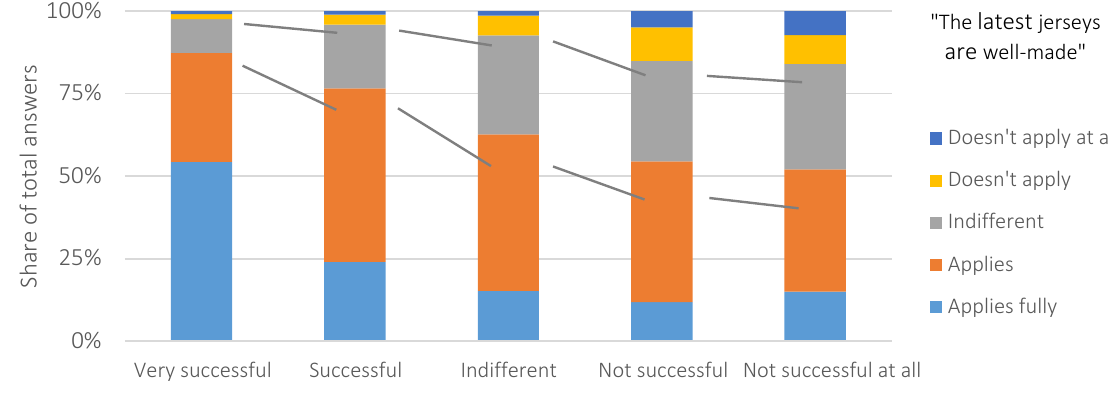
Figure 1. Visualization of correlation of assessing sporting performance